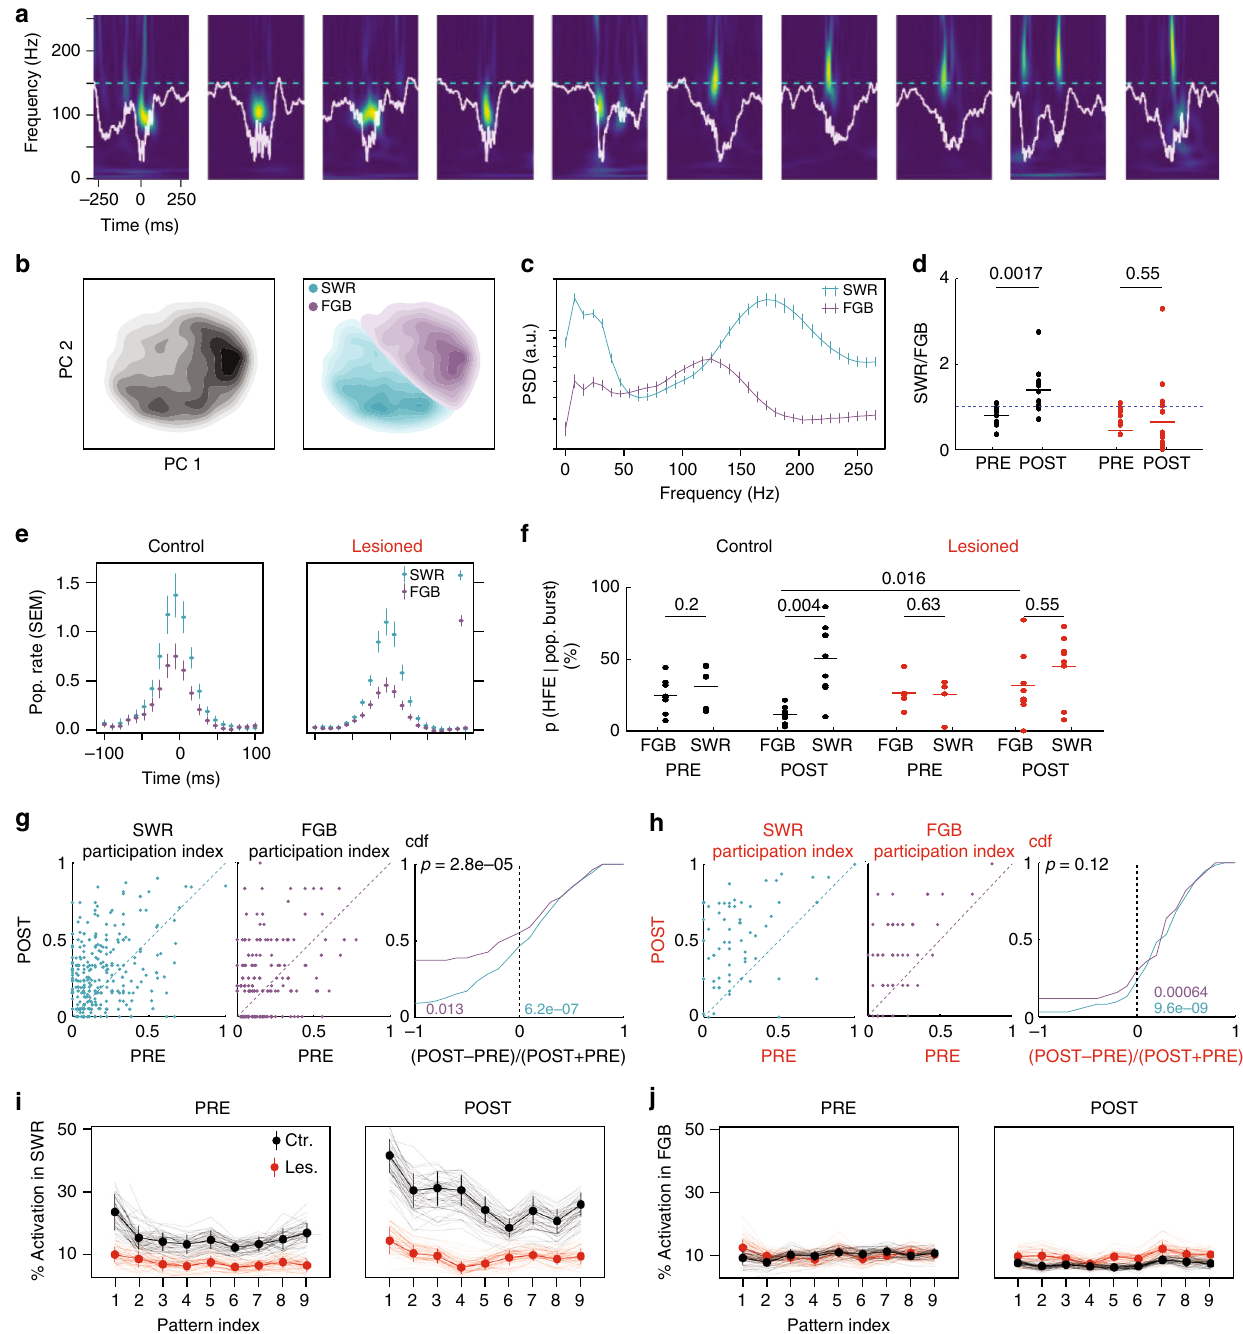
Fig. 5 Local fi eld potential correlates of pattern activation and place cell bursts. a Ten example traces (white) and corresponding power spectrograms of HFEs (color scale normalized; warm colors indicate high power). Dashed cyan line indicates 150 Hz. b Left: Density plot of principal component (PC) projections of the spectrogram from one example session (PRE and POST) of a control animal. Right: Same plot with cluster labels. c Power spectral densities from ( b ). Error bars: 99th-percentile. d Fraction of SWRs vs. FGBs in the PRE and POST epochs (black: Control; red: MEC-lesion, blue dashed line indicates unity; see main text for statistics). e Population rates (cell-wise z -scored) triggered by the peak of the HFE. Error bars are 68th-percentiles. f Percentages of place cell bursts that coincide with an HFE (±150 ms, colors as ( d )). p Values above bars from signed-rank tests (Control PRE: s.r. = 8, n = 8; Control POST: s.r. = 0, n = 9; MEC-lesioned PRE: s.r. = 5, n = 5; MEC-lesioned POST: s.r. = 13, n = 8) and a ranksum test when comparing between animal groups (see main text). g Cell-wise participation in signi fi cant spatial sequences. Only signi fi cant replays are considered in a ±150 ms window triggered by an HFE. Right: CDF of relative changes. p Value (black) from ranksum test for group medians (r.s. = 83,934, n SWR = 306 place cells, n FGB = 198 place cells). Colored p values from signed-rank tests for median being negative (purple, FGB; s.r. = 7180, n = 198 place cells) or positive (cyan, SWR; s.r. = 29305, n = 306 place cells). h Same as ( g ) for MEC-lesioned animals (ranksum test comparing FGB and SWR: r.s. = 4573, n SWR = 70, n FGB = 51; purple p value from signed-rank tests for positive median, s.r. = 1007, n = 51; cyan: s.r. = 1985, n = 70). i Percentage of pattern activation events coinciding with an SWR (±50 ms). Labels on the x -axis indicate the pattern (principal component) from the co-activation analysis (see main text for statistics). Error bars indicate 66th-percentiles. j Same as ( i ) for FGBs NATURE COMMUNICATIONS| (2019) 10:1341